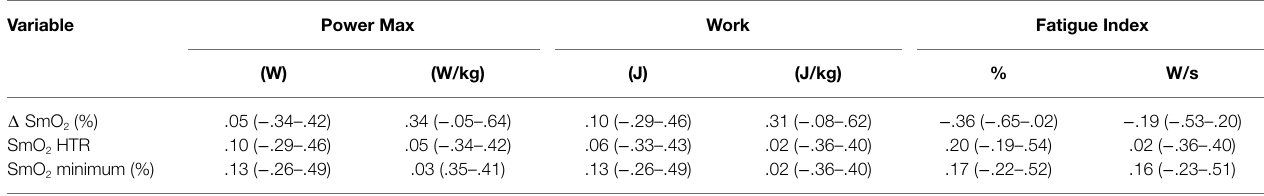
The numbers in the table presenting r values and coefficient interval for r in the brackets. ∆ SmO 2 (%)—SmO 2 difference between resting and minimum values. SmO 2 HTR—half time for SmO 2 to reach the maximal